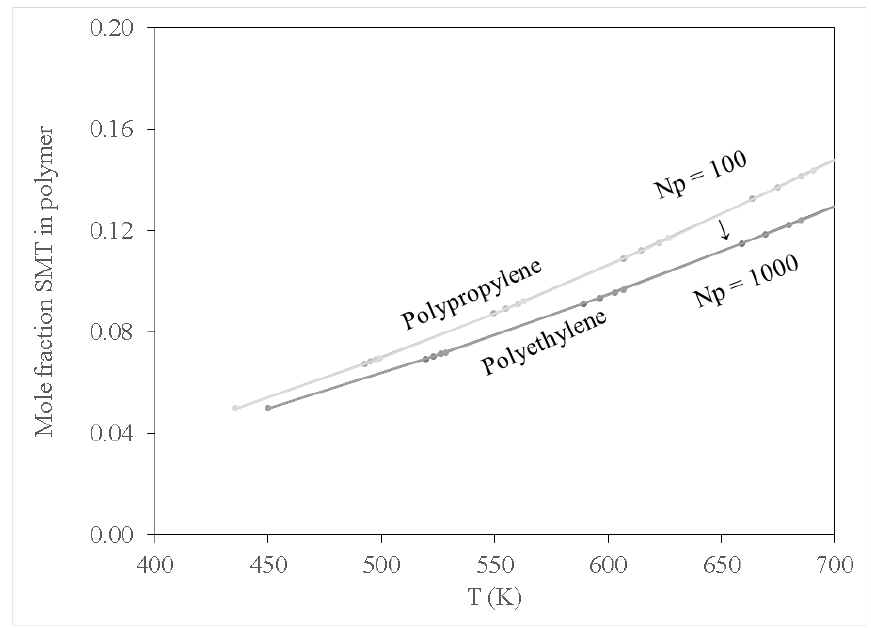
Figure 4. Effect of temperature on SMT content of PP and PE with respect to the degree of polymer- isation (Np).